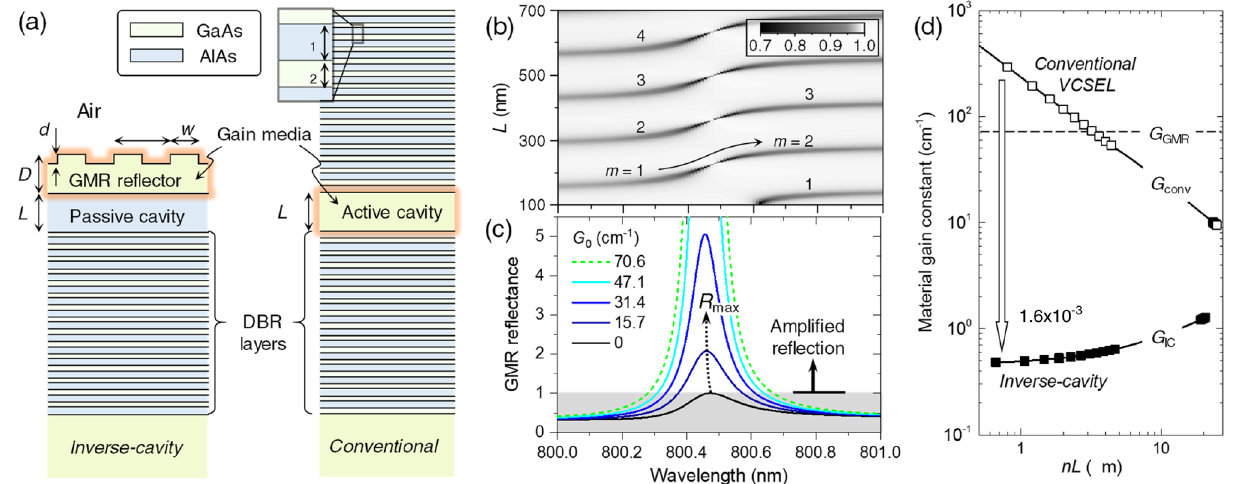
Figure 3. VCSEL employing an inverse-cavity structure. ( a ) Geometry of a GaAs-AlAs-based inverse- cavity structure in comparison with a conventional VCSEL structure. Optical gain is applied to the GaAs guided-mode-resonance (GMR) reflector for the inverse-cavity structure and GaAs Fabry-Pérot cavity for the conventional VCSEL structure. ( b ) Reflectance spectrum on L - λ plane for an inverse-cavity structure under normal incidence from the air cover. Geometrical parameters and optical constants are d = 25 nm, D = 475 nm, Λ = 226.5 nm, w = Λ /2, δ 1 = 67.8 nm, δ 2 = 55.6 nm, and refractive indices 2.95 for AlAs and 3.6 for GaAs. Material gain constant G 0 = 0 in the GaAs GMR reflector for this spectrum and m denotes a Fabry-Pérot (FP) order. ( c ) Amplified internal reflectance spectra due to a gain-assisted GMR for increasing G 0 . ( d ) Calculated threshold gain constants G IC for the inverse-cavity structure and G conv for the conventional VCSEL structure as functions of cavity optical path length nL . G GMR is threshold gain constant for the GMR in the absence of the bottom DBR layers ( L =